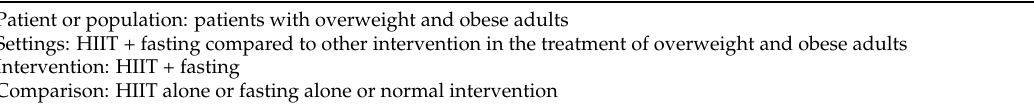
Table 5. Summary of